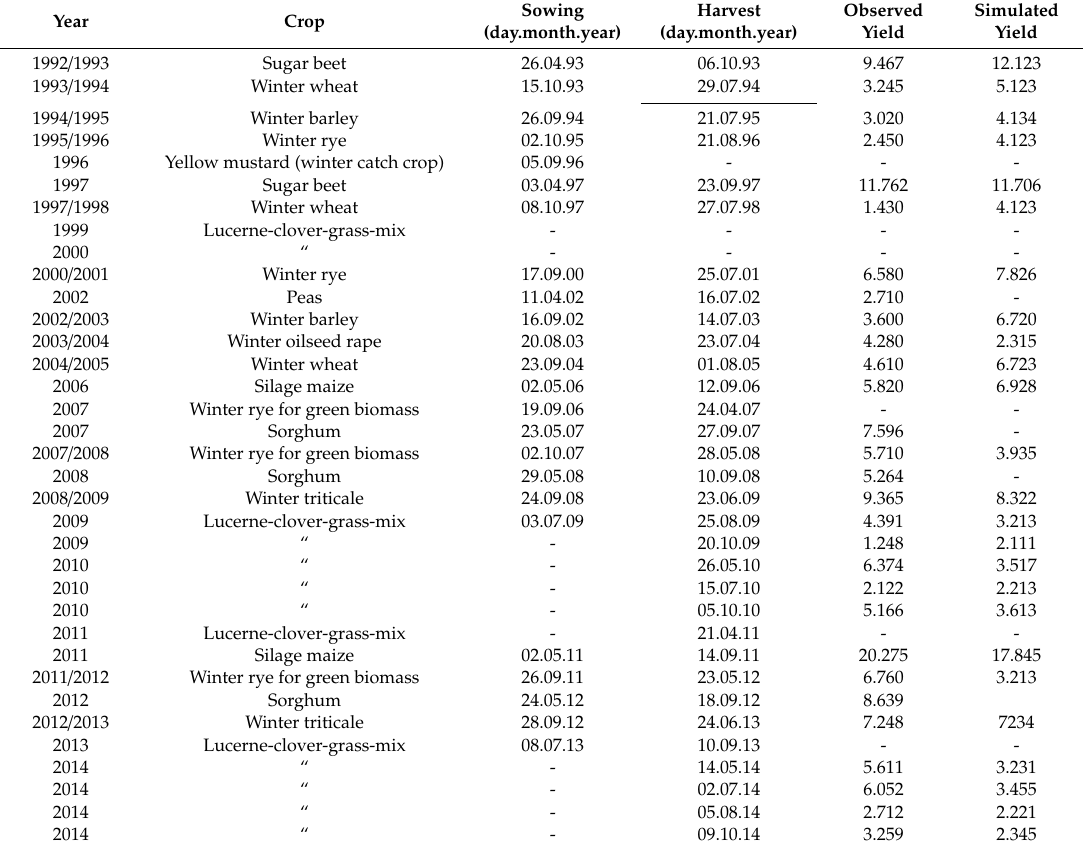
Sowing Harvest (day.month.year) (day.month.year)